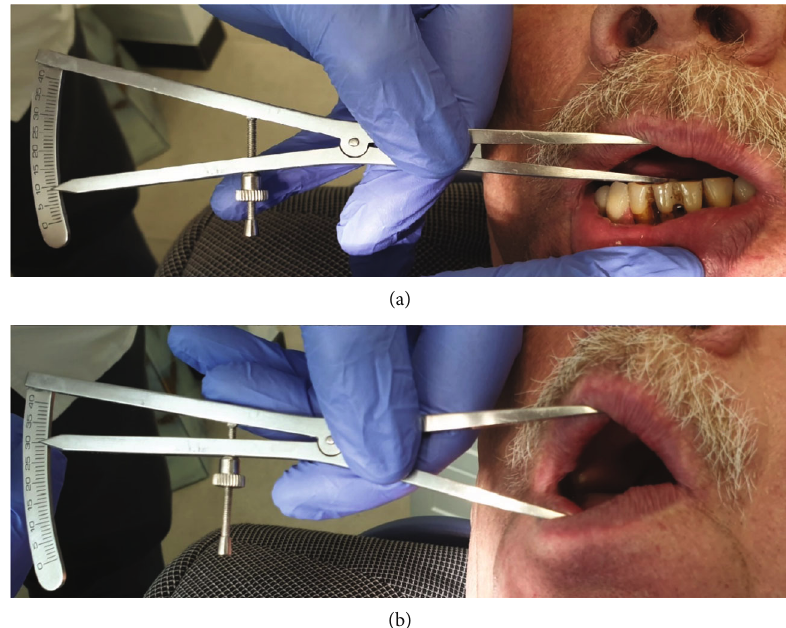
Figure 1: (a) Clinical examination of patient on initial visit revealed limited and painful mouth opening to 9.5 mm. (b) Examination at 10- week follow-up after the treatment revealed increased mouth opening to 30mm.